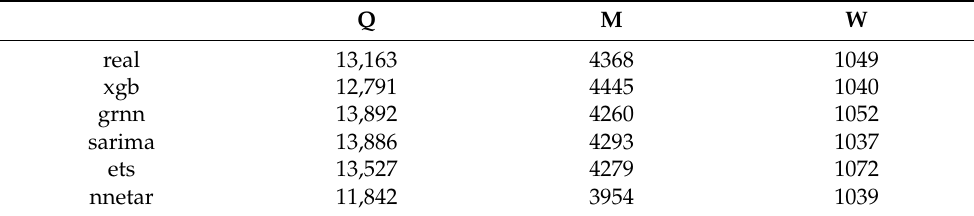
Table 7. 32% of the minimum demand for renewable energy (in